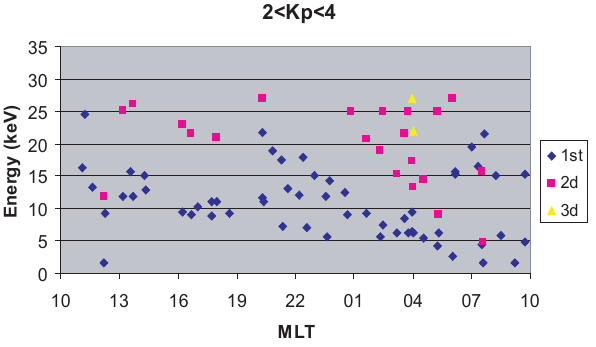
Fig. 9. Characteristic energy of the low energy nose structure vs. MLT, for different K p